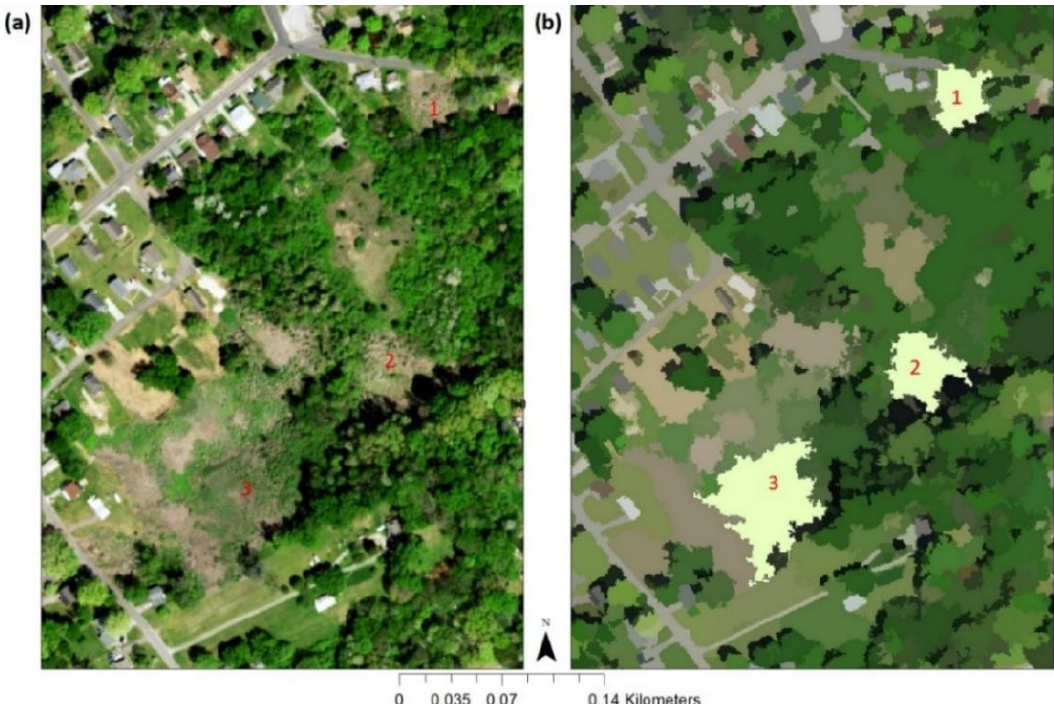
Figure 2. (a) A scene of National Agriculture Imagery Program (NAIP) image taken in April 2016 with kudzu patches. Kudzu patch 1 and 2 represent relatively pure kudzu patches, and 3 represents kudzu patch mixed with other vegetation. (b) segments of (a) with 1, 2, and 3 correspond to the three kudzu patches in (a) .